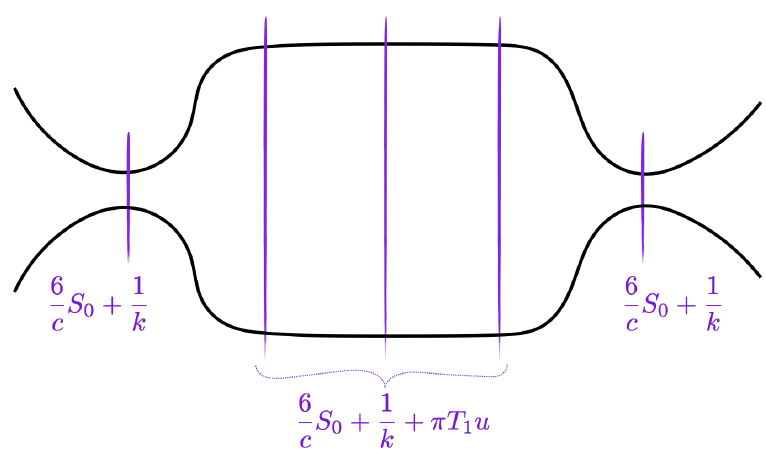
S gen . u (cid:29) u Page . The QESs marked c